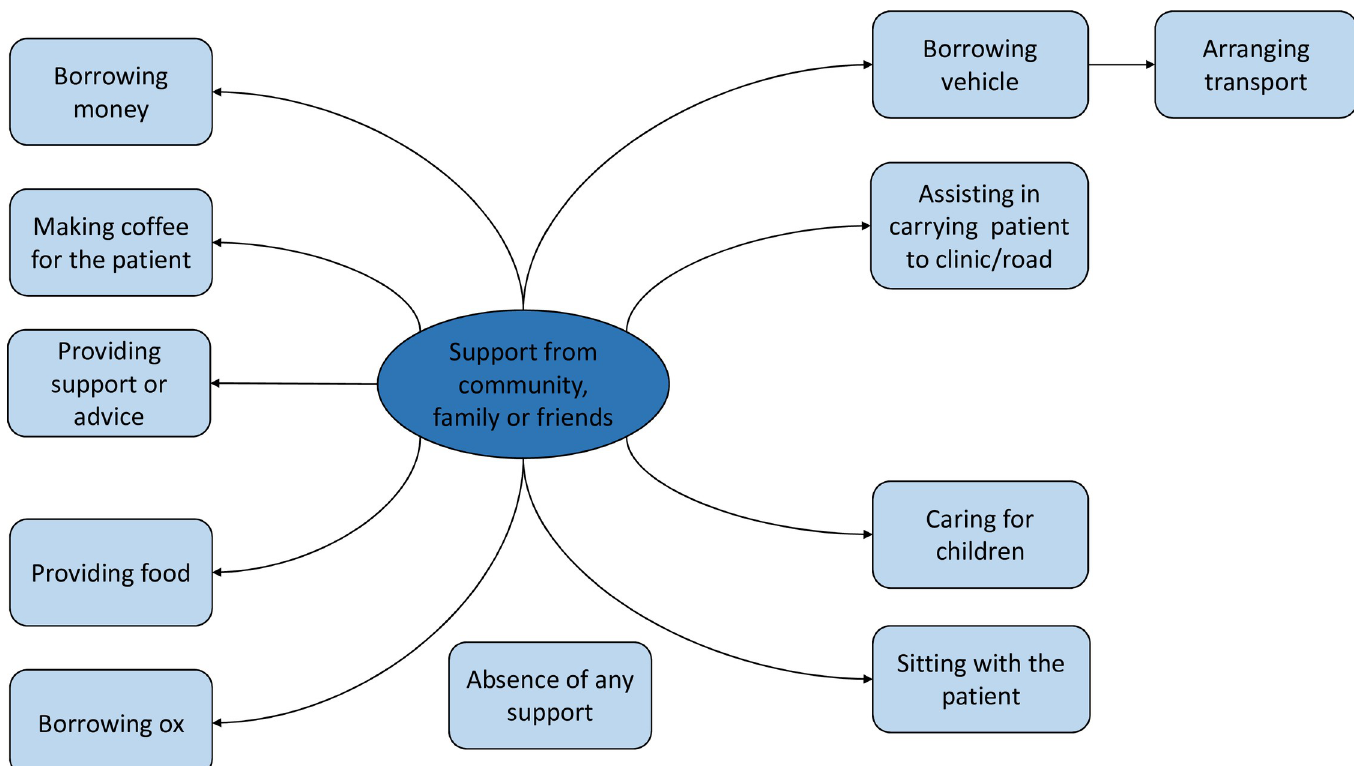
Fig 3. Support for caregivers from family and